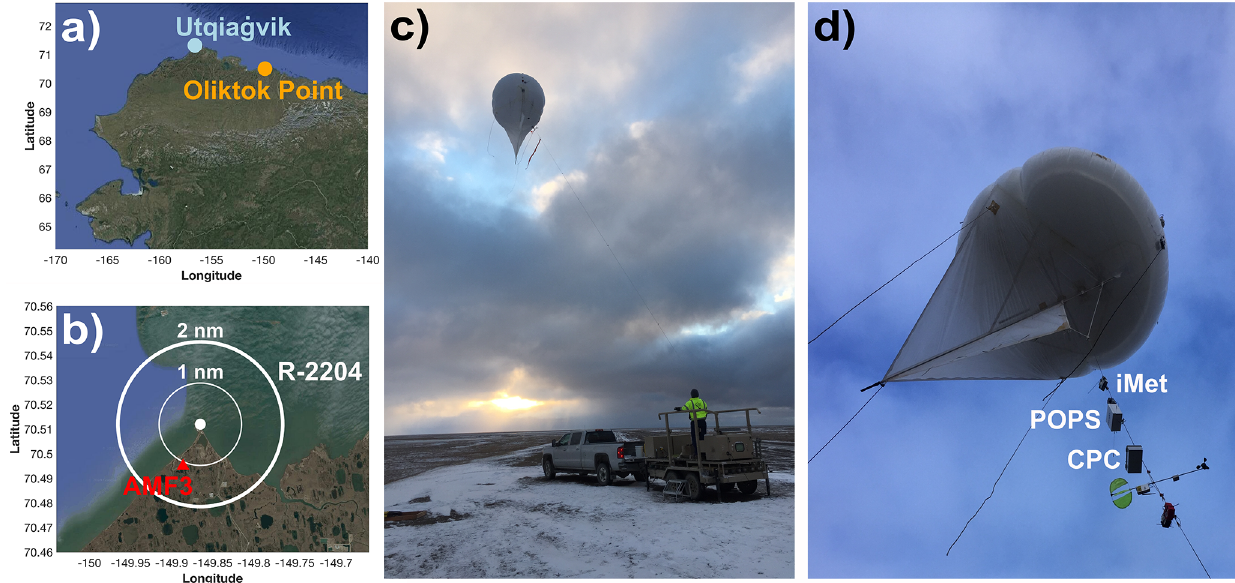
Figure 1. Maps illustrating (a) the location of Oliktok Point, Alaska, and (b) the scale (in nautical miles,nm) of the restricted airspace area (R-2204) set up for operation of the TBS with the location of AMF3 (red triangle). The map was created using satellite imagery obtained through the © Google Earth Application Programming Interface. Also shown are images of the TBS (34m 3 helikite), including (c) the Sandia National Laboratories winch trailer used for flight and (d) a close-up of a typical instrument payload. Only the instruments mentioned in this paper are